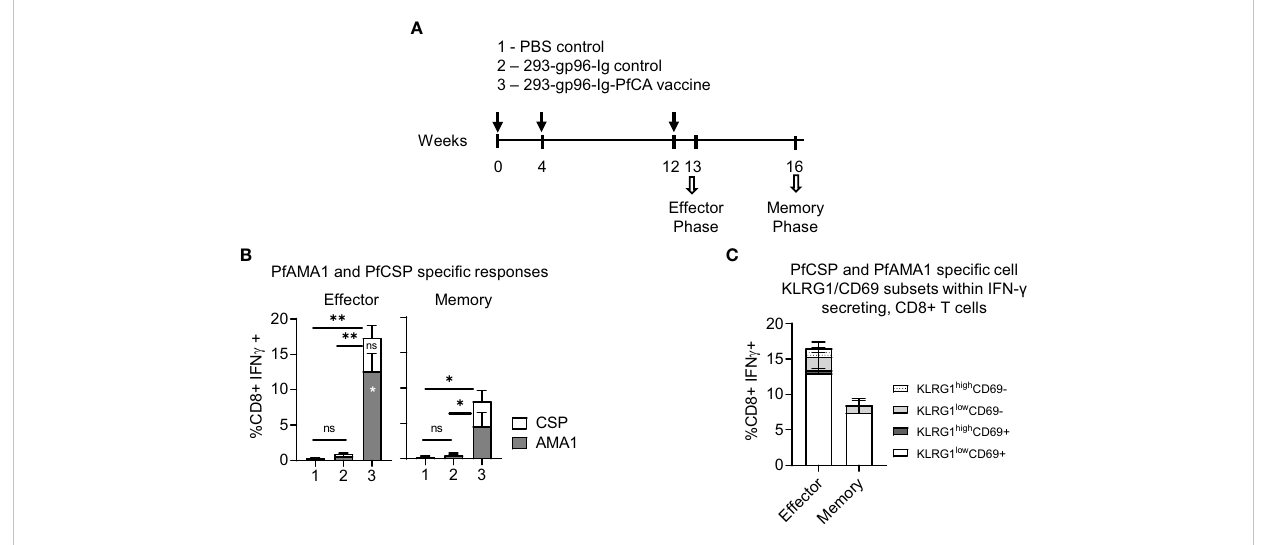
FIGURE 3 293-gp96-Ig-PfCA vaccinated mice induce antigen-speci fi c, intrahepatic memory CD8+ T cells. (A) Characterization of antigen-speci fi c, intrahepatic memory CD8+ T cell responses in C57BL/6 mice at effector (5 days post-last dose) or memory phase (4 weeks post-last dose). The mice received three doses 293-gp96-Ig-PfCA vaccine secreting 250ng/mL of gp96-Ig at week 0, 4 and 12 via SC route. Control mice received gp96-Ig alone, mock cells secreting 250ng/mL of gp96-Ig, or PBS. Total intrahepatic lymphocytes were cultured overnight in medium only or with a pool of overlapping PfCSP and PfAMA1 peptides. Following surface and intracellular staining, cells were analyzed by fl ow cytometry to determine the frequency of PfAMA1 and PfCSP speci fi c (B) CD8+ T cells secreting IFN- g . (C) KLRG1 low/high and CD69+/- cells within CD3+CD8+ T cells secreting IFN- g . Data represents mean ± standard deviation. Asterisks (*) denote signi fi cant differences between vaccinated mice (n=6) and mock